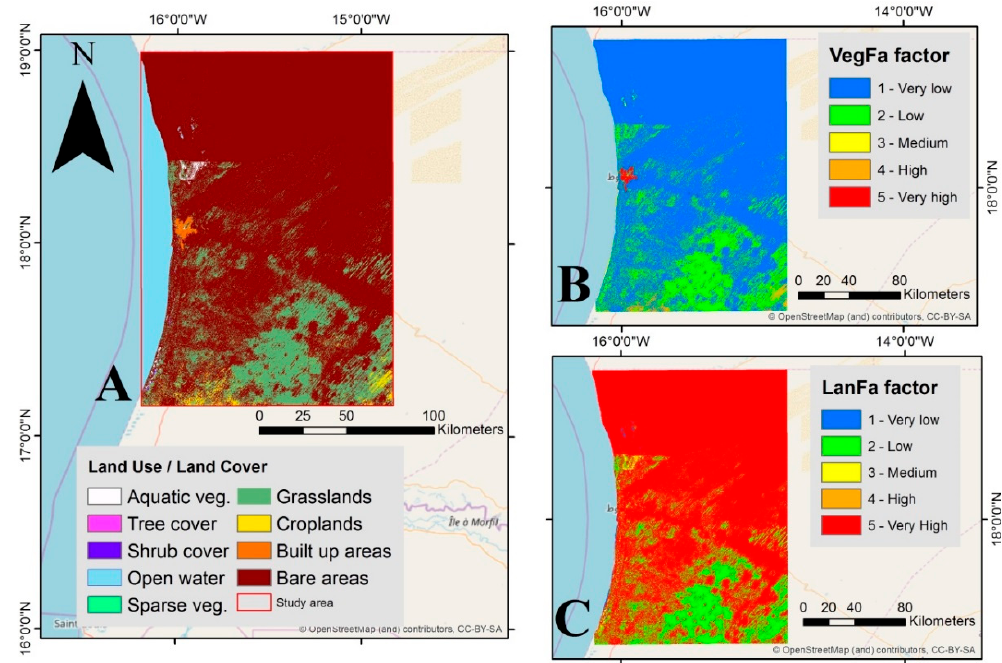
Figure 5. ( A ) Land Use/Land Cover map, ( B ) vegetation factor (VegFa) and ( C ) land factor (LanFa). Source: ESA CCI Land Cover of Africa 2016.